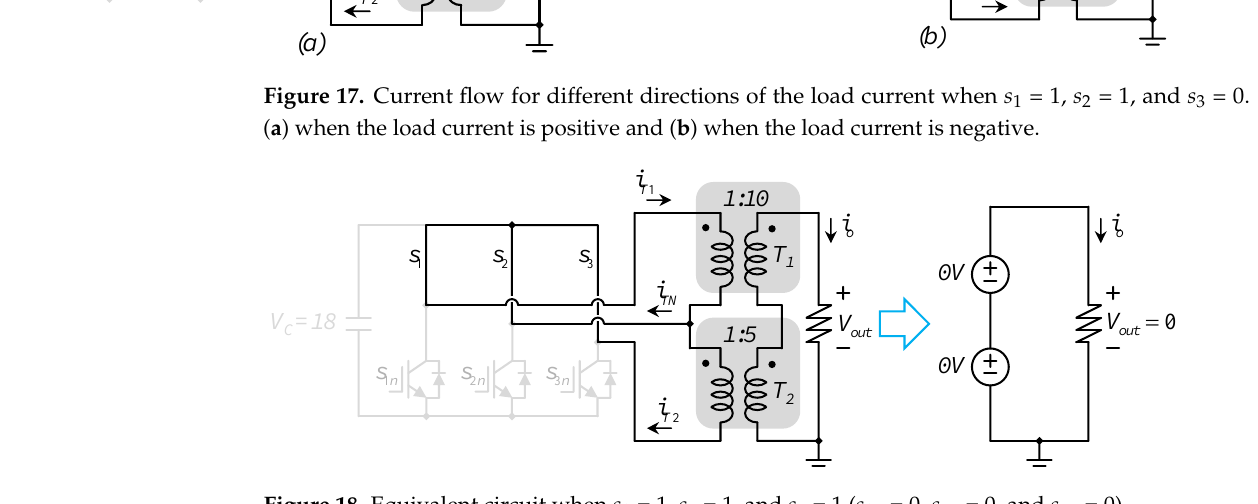
Figure 18. Equivalent circuit when s 1 = 1, s 2 = 1, and s 3 = 1 ( s 1 n = 0, s 2 n = 0, and s 3 n = 0).